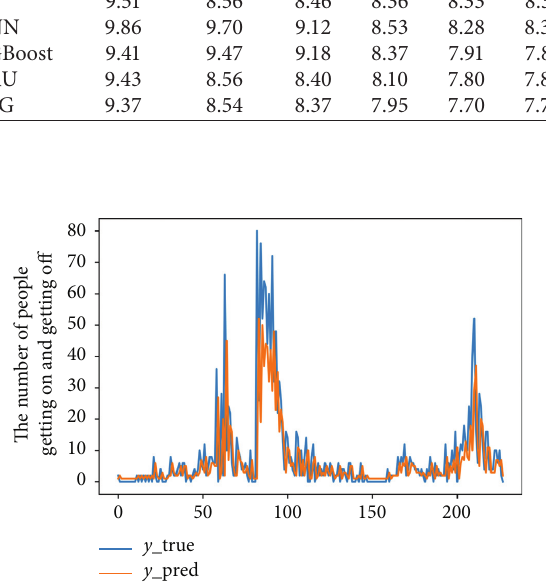
Figure 20: Regression integration prediction results when the time step is 15 min.